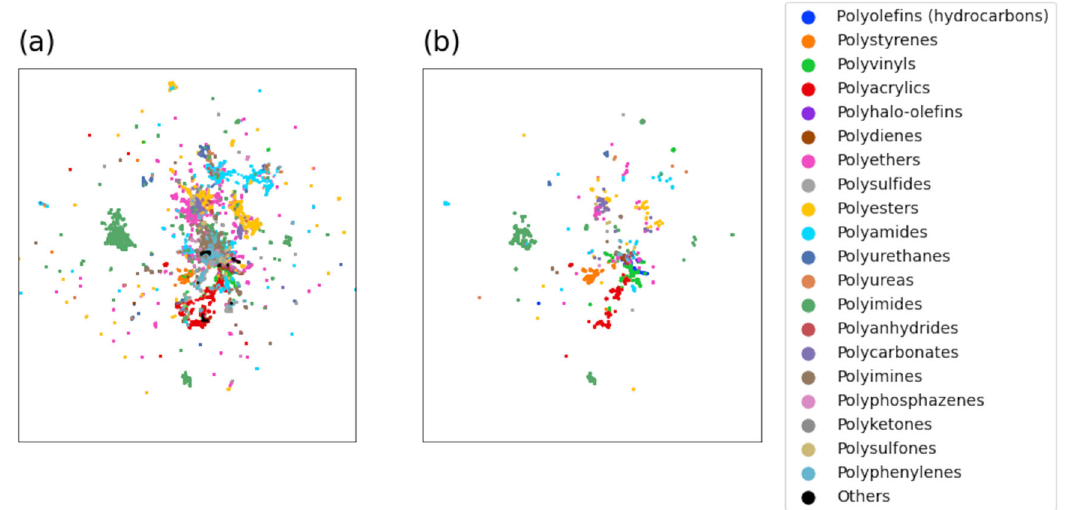
Fig. 2 UMAP plot visualizing the distribution of the polymer backbones. The UMAP plots show the distribution of ( a ) 15,335 homopolymers in PoLyInfo and ( b ) 1070 homopolymers calculated in this study. The 21 classes of the polymer backbones are color-coded according to the de fi nition of